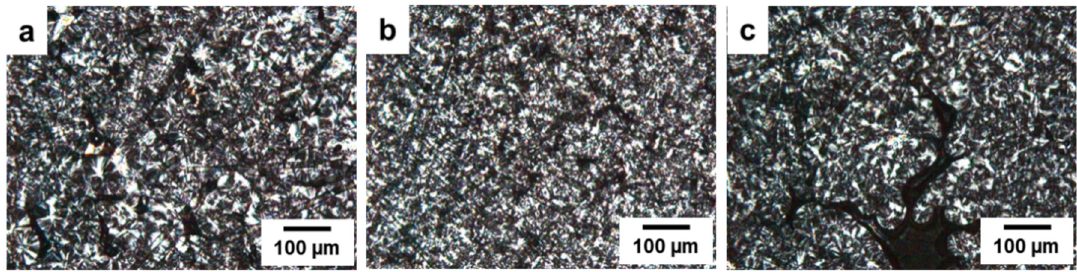
Figure 7. Polarized Light Microscopy images (100×) of the PP/SGF composites that are composed of ( a ) 0 wt % of a coupling agent; ( b ) 8 wt % of PP-g-MA as a coupling agent, and ( c ) 8 wt % of SEBS-g-MA as a coupling agent.